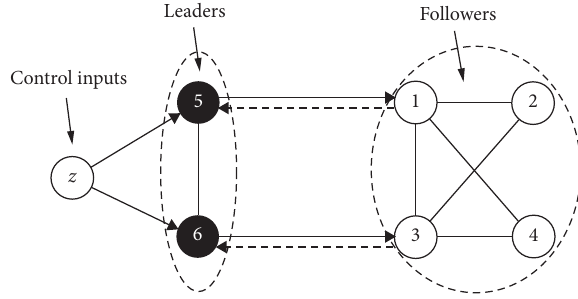
Figure 1: A schematic diagram of the networked